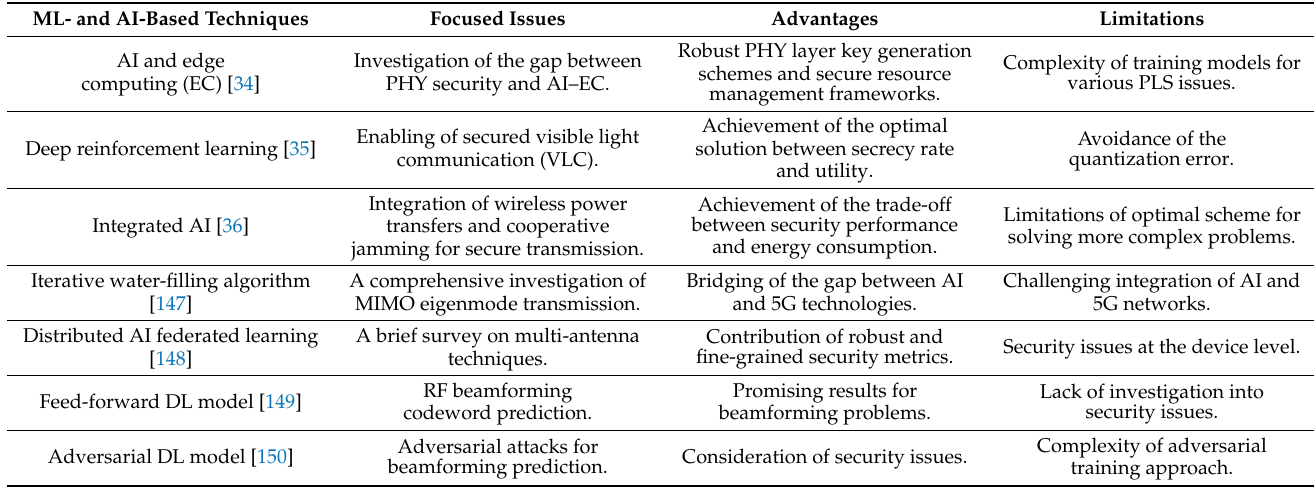
Table 4. Overview of ML and AI techniques for physical layer design and